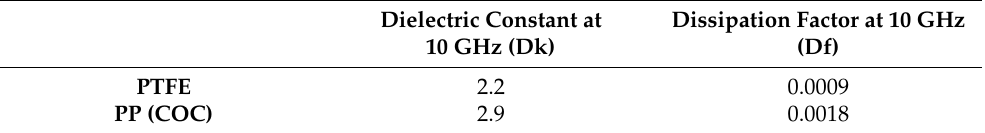
Figure 3. ( a ) PTFE substrate under the microscope. ( b ) Fabricated signal line on the PTFE substrate. Table 1. Electrical properties of PTFE and PP. Table 1. Electrical properties of PTFE and PP.